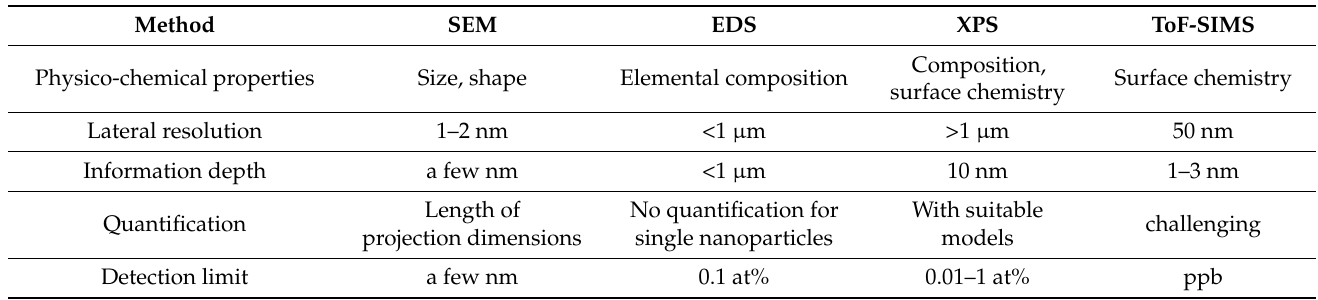
Table 1. Key properties of the